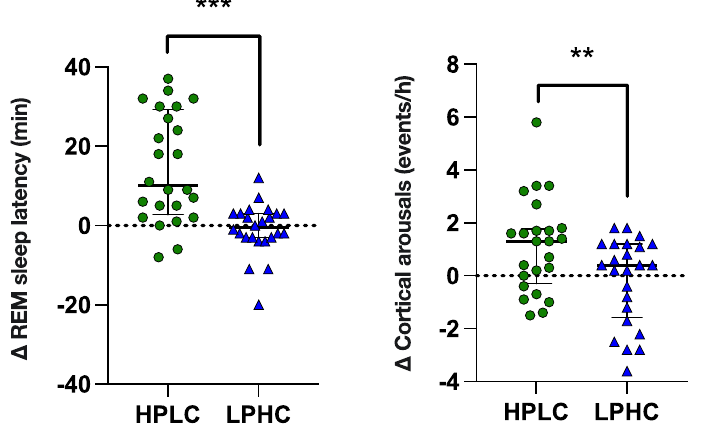
Figure 3. REM latency and arousals variation in response to HPLC vs. LPHC diets. Data are shown as median ± interquartile range with scatter-plots representing individuals’ data. p value: ** p < 0.01; *** p < 0.001.